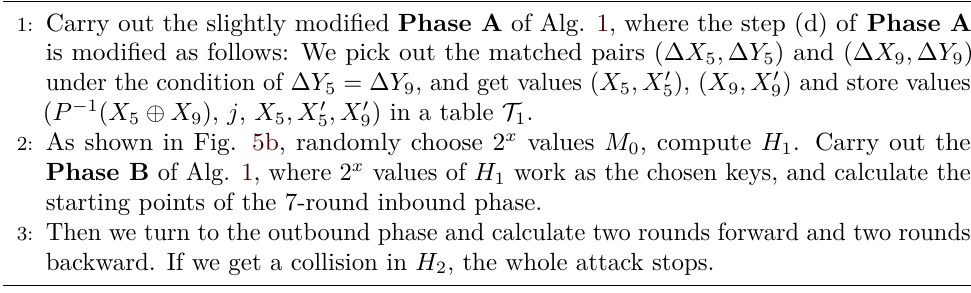
Algorithm 2 Generate 11-Round Collision for MMO Hashing Mode with Feistel-SP Block Cipher